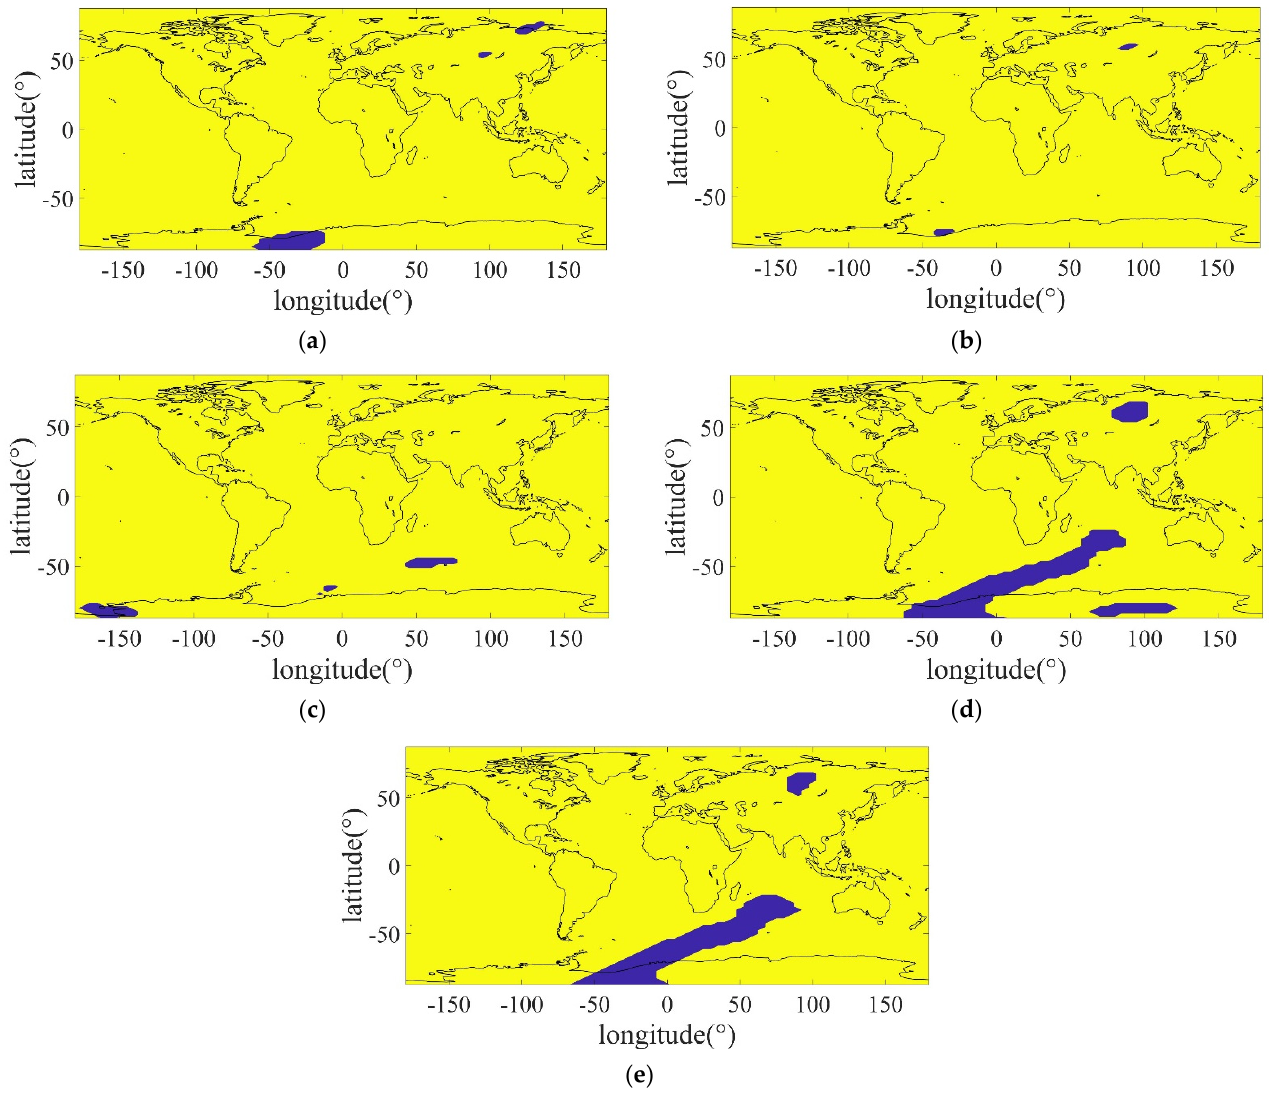
Figure 10. Region distribution of 0-value (blue region) of four systems at UT 0:00, DOY 308, 2021. ( a ) GPS; ( b ) GLONASS; ( c ) Galileo; ( d ) BDS; ( e ) BDS (MEO + IGSO). Table 2. The mean number of each system 0-value in different areas during ionosphere active days (DOY 288–317 in 2021).